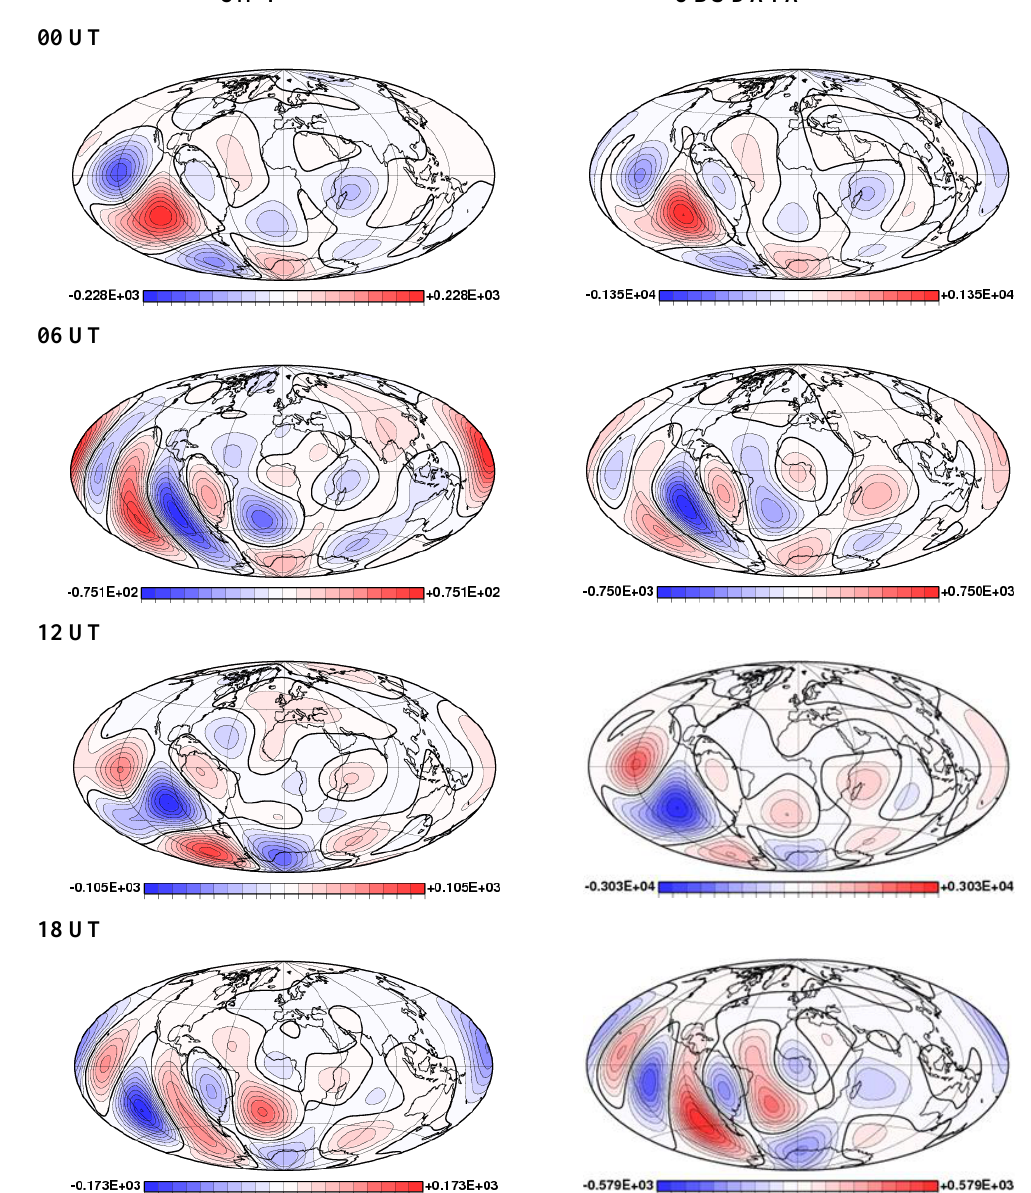
Figure 8. Similar to Fig. 5 but for spherical harmonic degree truncation 7 ( n = 7). Better and improved coherence between the CM4 and observatory station data, i.e. better prediction of the observatory station data by the